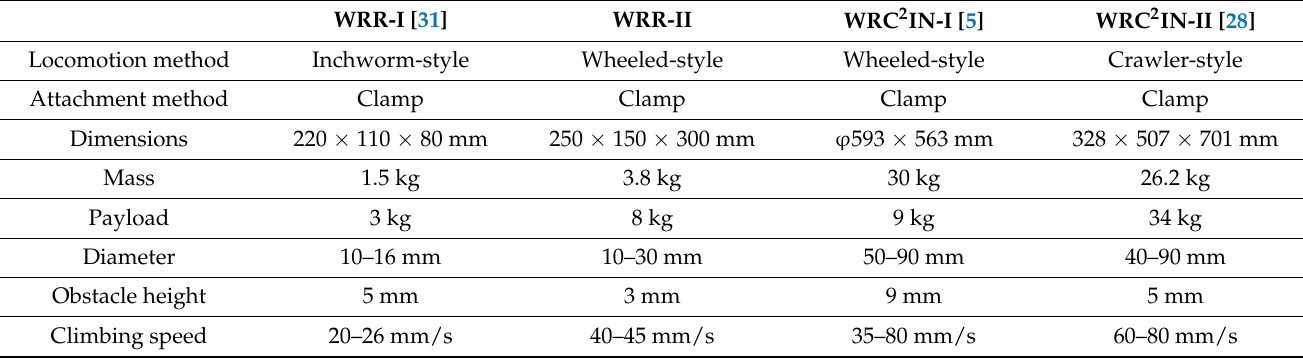
Table 3. The performance comparison of the robots.